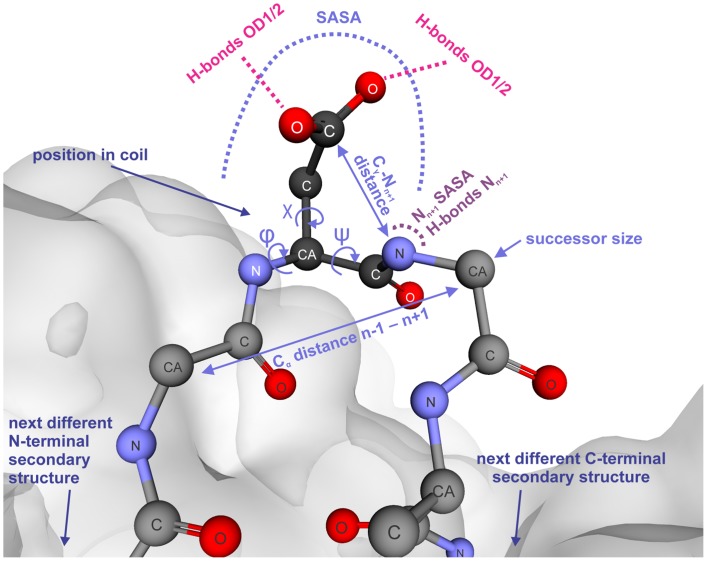
Parameters characterizing Asn and Asp residues in a structural environment outlined at an exemplary Asp residue.Parameters describing the carboxyl/amino group leaving tendency, the transition state accessibility, the Nn+1 nucleophilicity, and the structural environment are depicted in pink, light blue, purple, and dark blue, respectively. Parameter names are used as in Table S1.